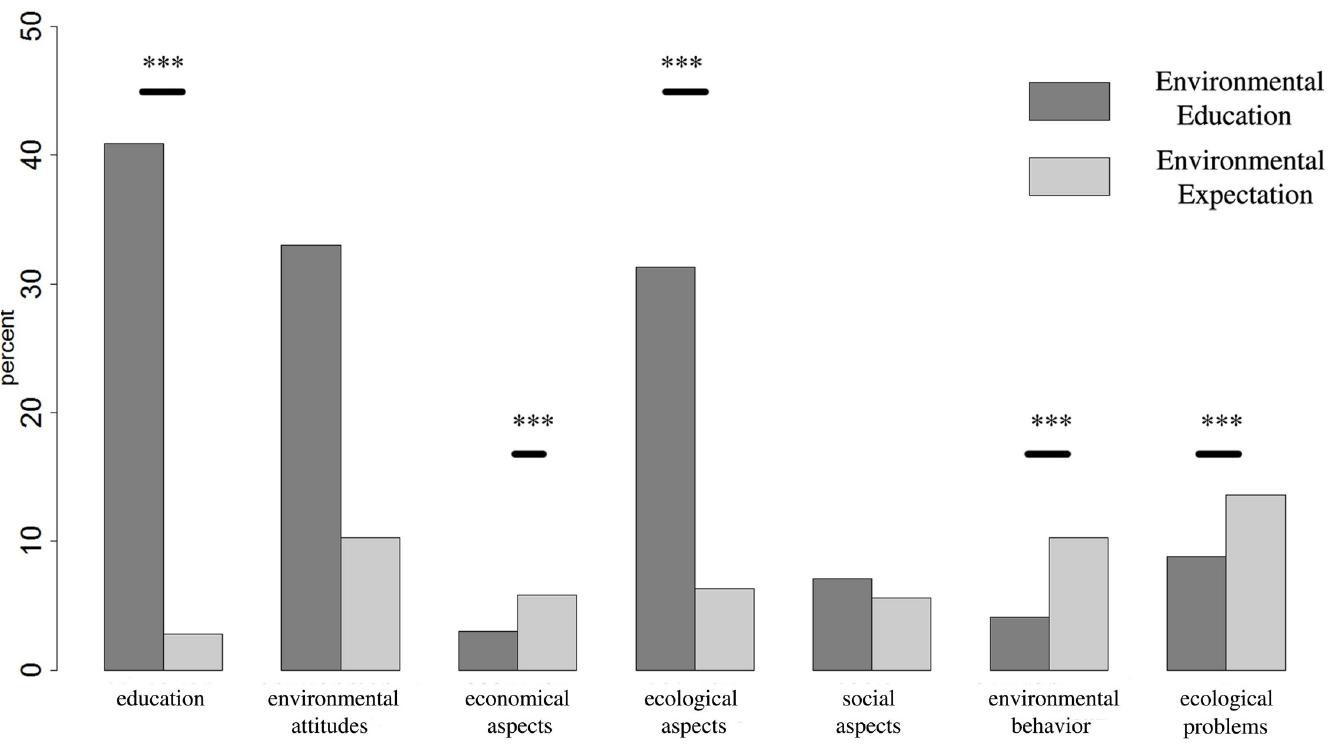
Fig 7. Conceptions about ‘Environmental Education (EE)’ (row of order see Fig 2) and individual ‘environmental expectations’.